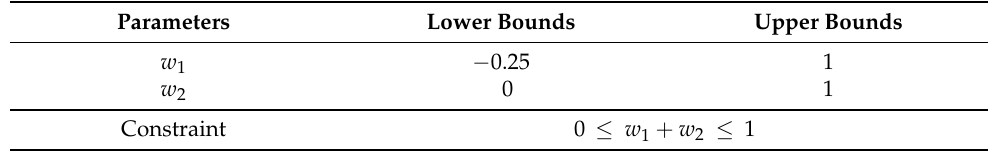
Table 2. Bounds and constraint of the design